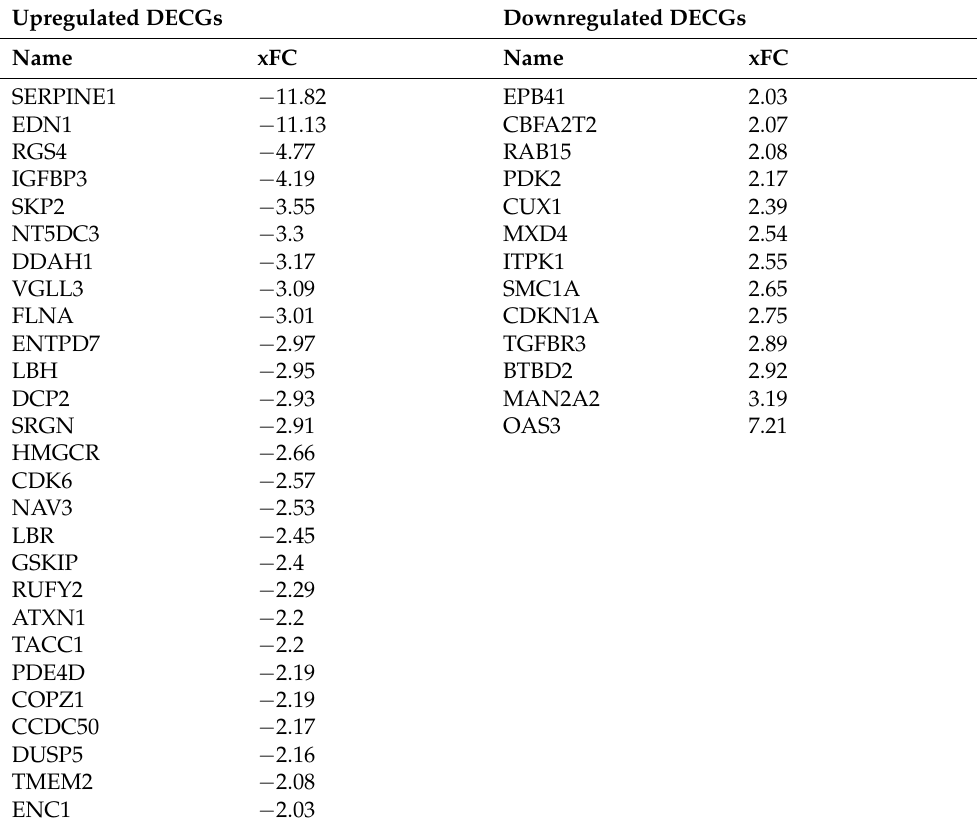
Table 1. x-fold changes (xFC) of DECGs with predicted miR339-5p binding site. Upregulated DECGs Downregulated